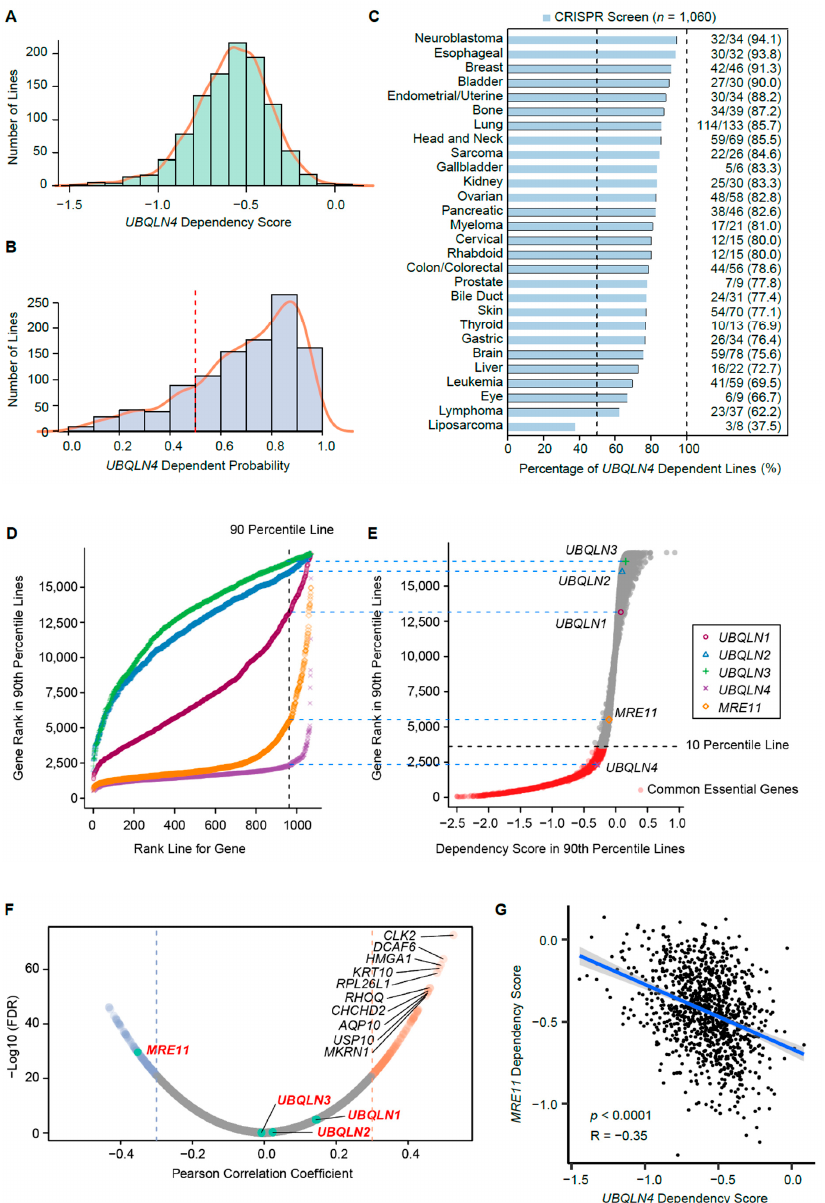
Figure 3. Utility of UBQLN4 as a biomarker of prognosis and treatment resistance. ( A ) His- togram of UBQLN4 dependency scores of all cell lines in the Cancer Cell Line Encyclopedia (CCLE) datasets. ( B ) Histogram of UBQLN4 dependent probability scores of all cell lines in CCLE datasets. ( C ) Frequency of UBQLN4 -dependent cancer cell lines by different cancer types in the CCLE dataset. Cell lines that have a larger UBQLN4 dependent score than 0.5 are defined as UBQLN4 dependent. ( D ) The relationship of UBQLN1-4 and MRE11 between a gene’s score rank in a cell line and the cell line’s rank for that gene using dependency scores of all cell lines in CCLE datasets, with gene ranks in their 90th percentile of least dependent lines highlighted. ( E ) Distribution of gene ranks for the 90th percentile of least dependent cell lines for each gene and dependency score in 90th percentile lines. Black dotted lines indicate the top 10 percentile most depleting genes in at least 90% of cell lines. The y-axis is equivalent to the y-axis in D at the 90th percentile mark, as indicated by the blue dotted lines. ( F ) Volcano plot of Pearson’s correlation coefficients between UBQLN4 gene dependency scores and dependency scores of each gene of all cancer cell lines in CCLE datasets. ( G ) Pearson’s correlation of UBQLN4 and MRE11 dependency scores of all cancer cell lines in CCLE